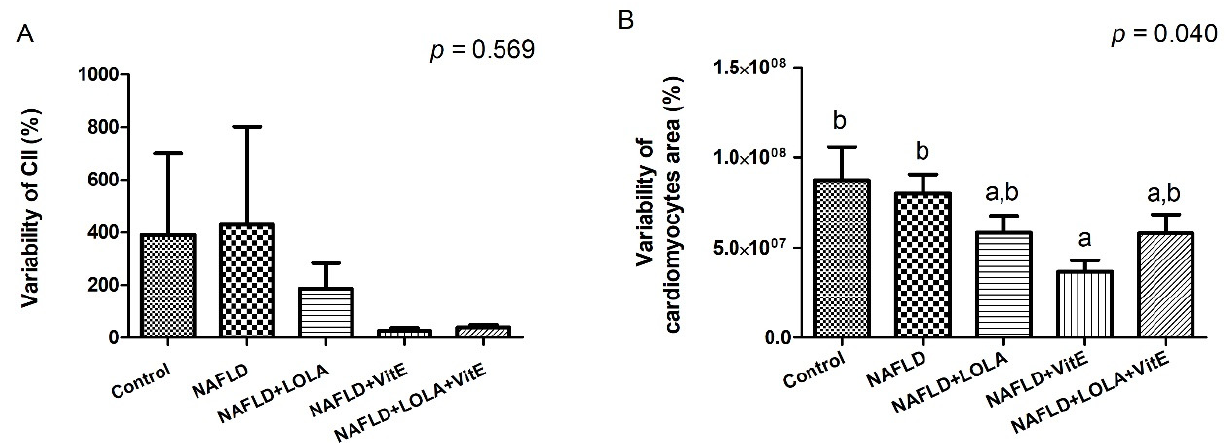
Figure 5. Cardiomyocytes morphometric analysis. ( A ) Cardiomyocytes irregularity index (CII); ( B ) variability of cardiomyocyte area. Data expressed as median (25th–75th percentile), Kruskal–Wallis test. Different letters indicate a significant difference between groups ( p < 0.05). LOLA: ornithine aspartate; NAFLD: nonalcoholic fatty liver disease, and VitE: vitamin E.